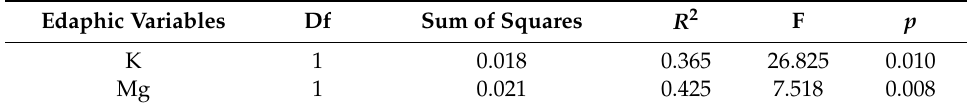
Figure 2. ( a ) Detrended correspondence analyses and ( b ) canonical correspondence analysis (CCA) ordination plots based on Hellinger-transformed abundance data of fungal guilds detected in the soil of three Pinus patula stands of di ff erent ages. Plots shown in the same color are in the same stand (black, plots in the 5-year-old stand; yellow, plots in the 11-year-old stand; red, plots in the 36-year-old stand). Edaphic variables are shown in green. The percentages of explained variation by each axis are shown in ( b ). Table 3. Canonical correspondence analysis based on simple term e ff ects showing the significance ( p < 0.05) of edaphic variables when considering the Hellinger transformed data of the entire fungal guilds at the level of fungal community in the study